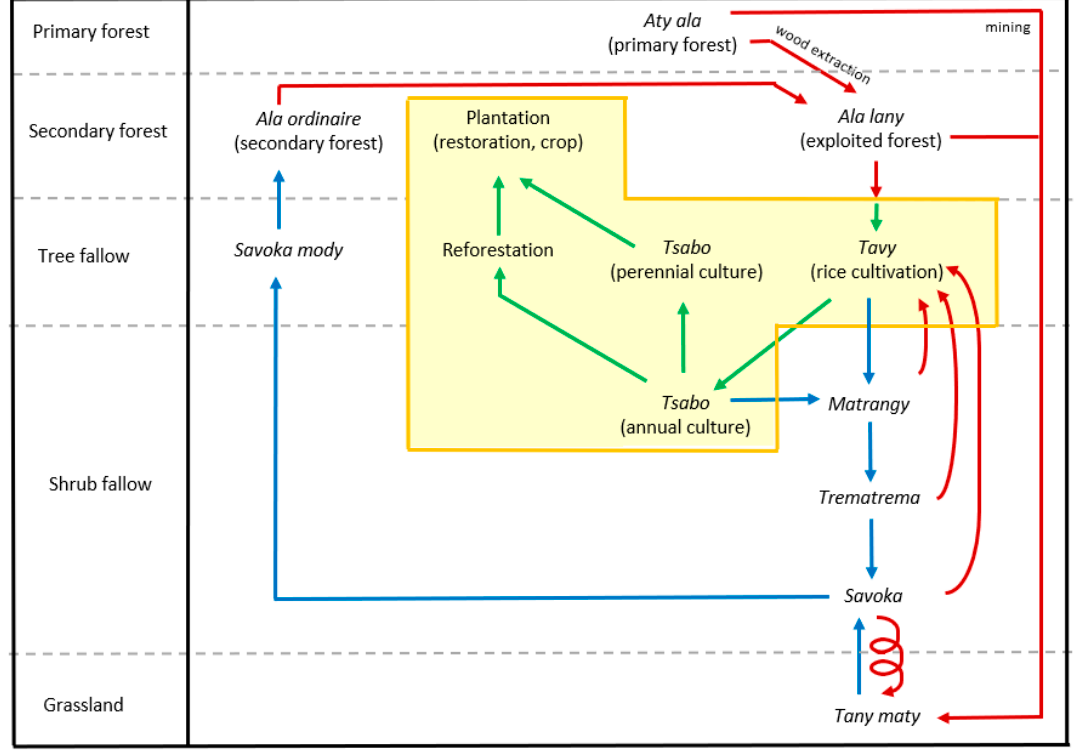
Figure 3. Conceptual model of land-use change and (post-) cultural dynamics in the Zahamena socio-ecological system. Natural succession (left panel) is compared with agricultural practices (yellow box); processes: tavy and/or cutting (red arrows), cultivating (green arrows), and resting periods/fallows (blue arrows). Local Betsimisaraka terms are in italics.